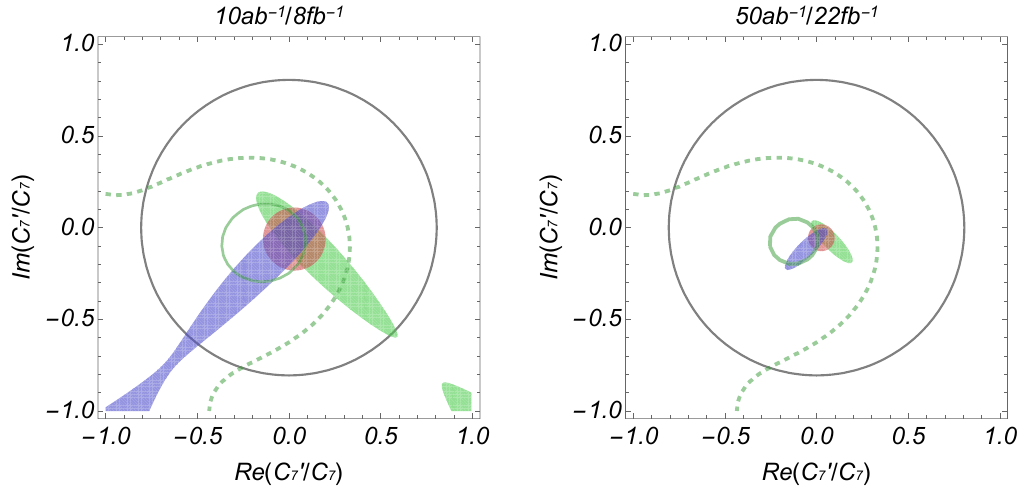
Figure 7 . Prospects for constraints on Re ( C ) and Im ( C ), at the three standard- (cid:31) 7 /C 7 (cid:31) 7 /C 7 + . The central value of deviations level, obtained from the two observables and S − S is chosen arbitrarily, while its uncertainty is estimated using results from ref. [24]. S − ) and Im ( C ), are Three sets of central values, yielding different contraints on Re ( C (cid:31) 7 /C 7 (cid:31) 7 /C 7 + , = 0 . 17 , 0 . 13 , 0 . 5 , 0 . 15 (blue), 0 . 13 , 0 . 04 , 0 . 3 , 0 . 3 (red) and chosen: , a I , b I S − } { − − } { − − } {S ), 0 . 13 , 0 . 03 , 0 . 15 , 0 . 5 (green). The uncertainties are taken as σ ( S I )= σ ( S I )= √ nσ ( S π + π − K 0 S γ { − − − } ) / √ n , where n = 2 corresponds to the number of Dalitz-plane regions. All and σ (a I )= σ (b I )= σ ( D the uncertainties are further scaled according to the increase of integrated luminosity. The grey and green contours are described in figure